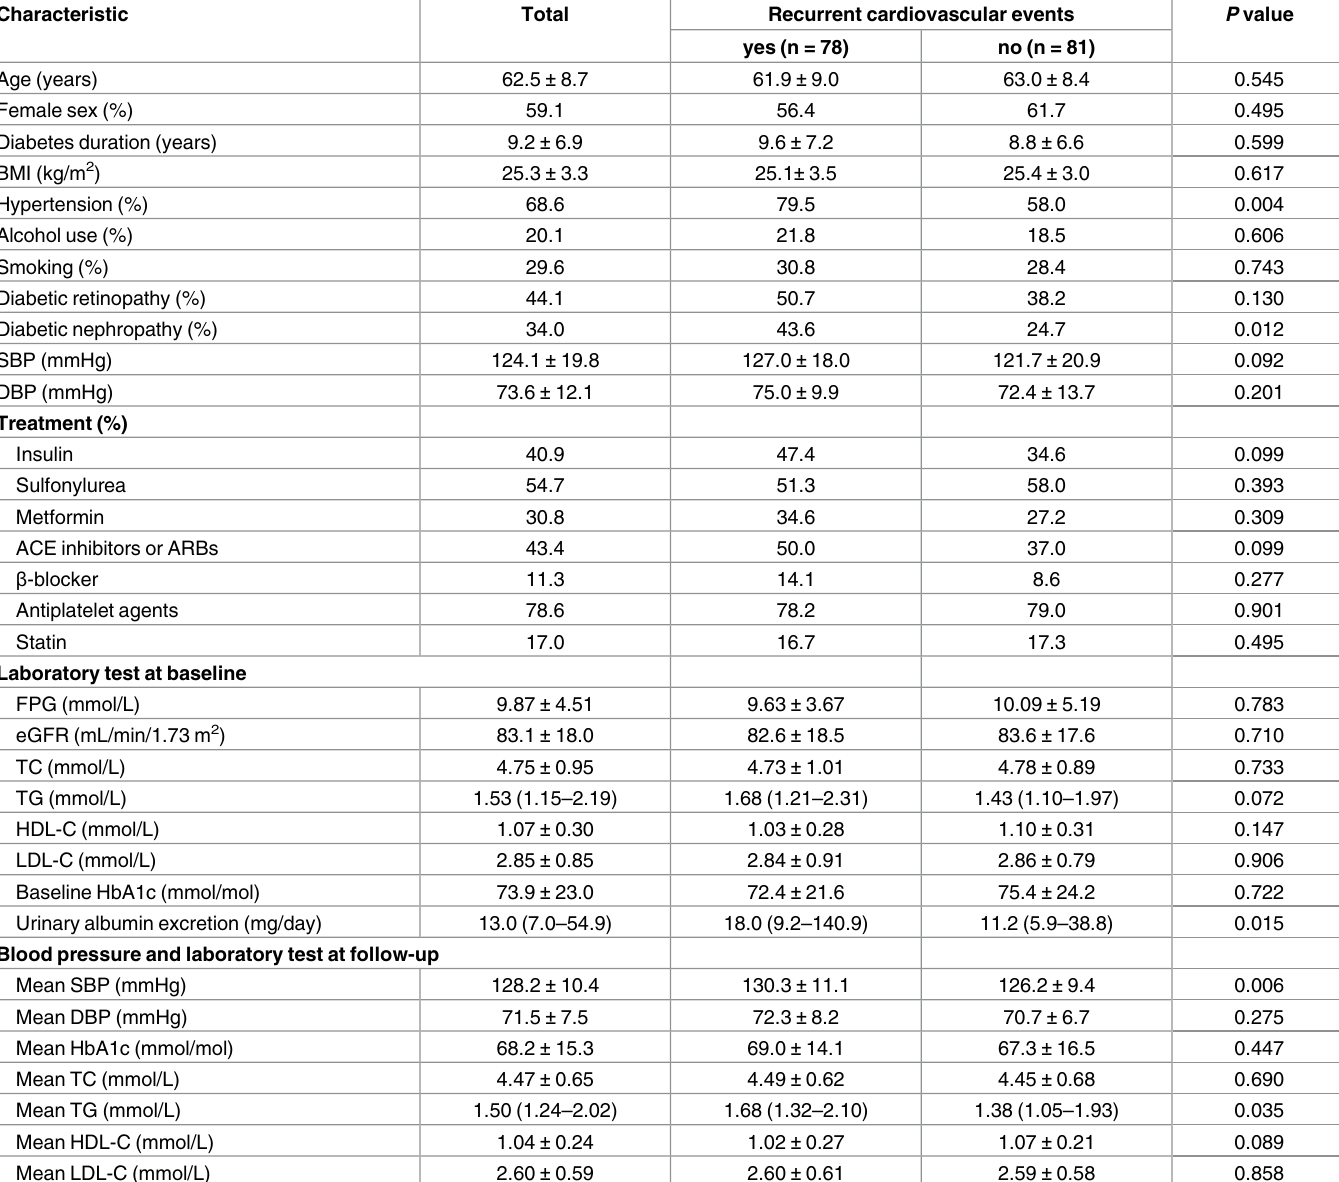
Table 1. Comparison of characteristics of participants with and without recurrent cardiovascular